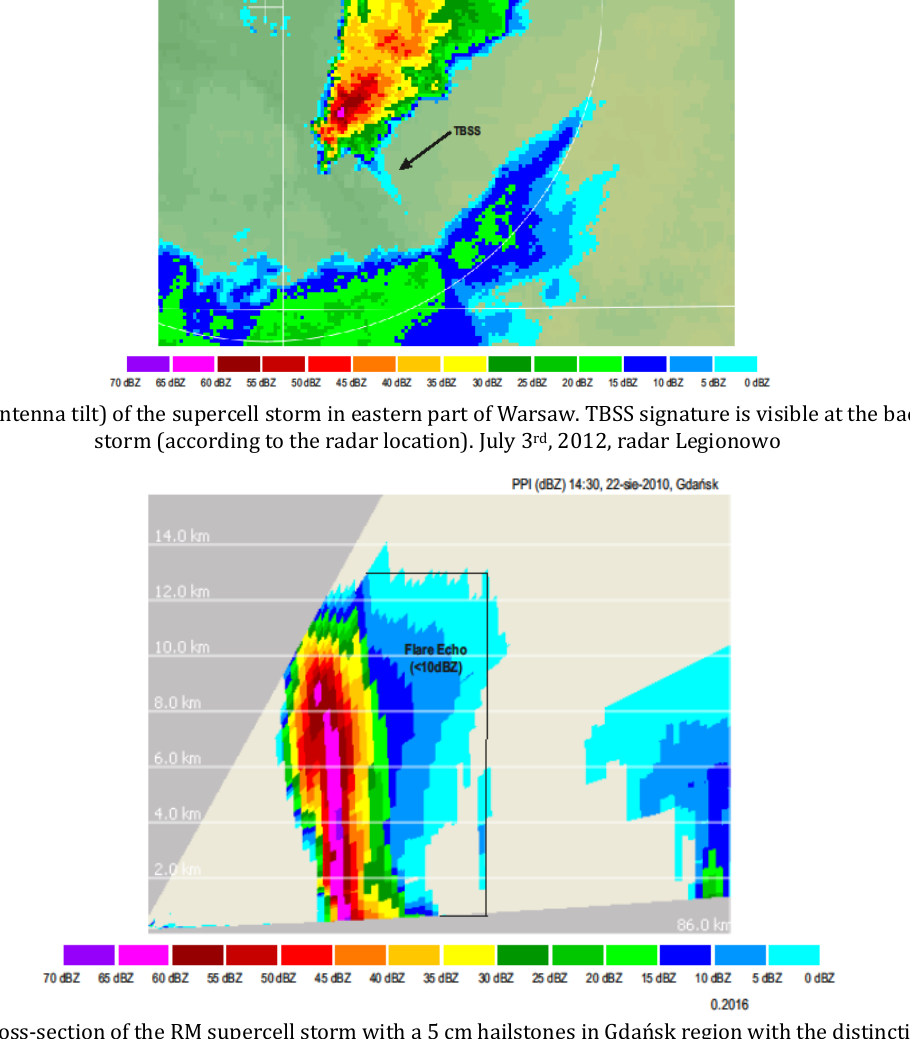
Fig. 9. Vertical cross-section of the RM supercell storm with a 5 cm hailstones in Gdańsk region with the distinctive flare echo. August 22 nd , 2010, radar